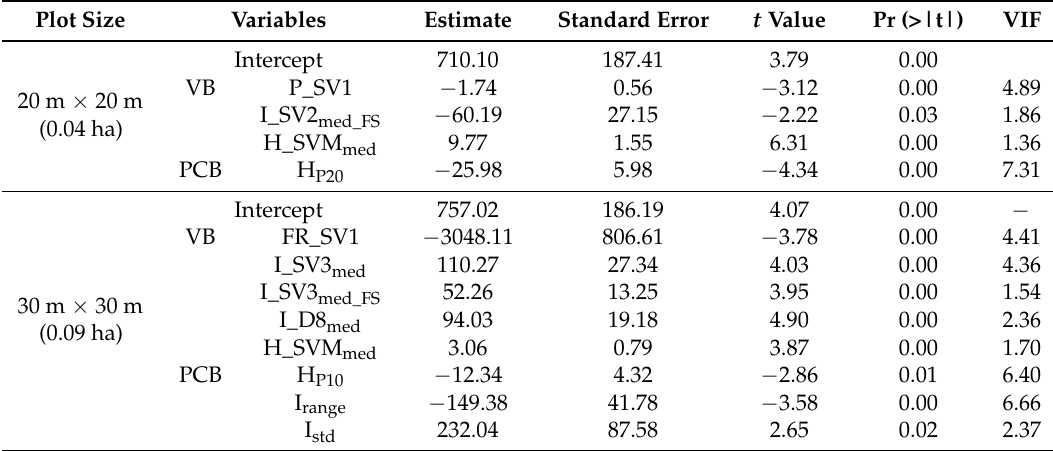
Table 3. Results of multiple regression analysis on 20 m × 20 m and 30 m × 30 m plot size.